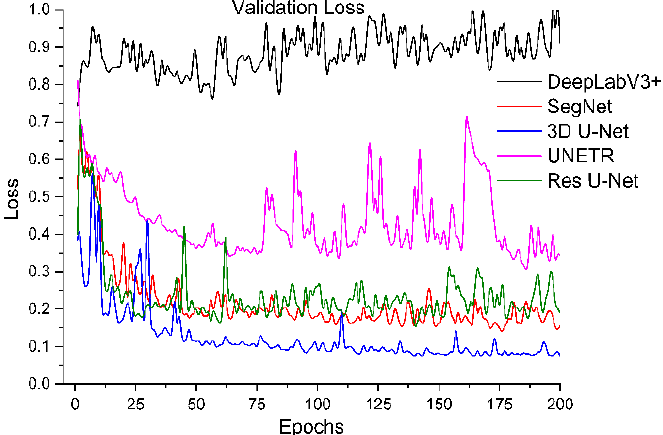
Figure 8. Validation loss of segmentation networks trained with the proposed training scheme.